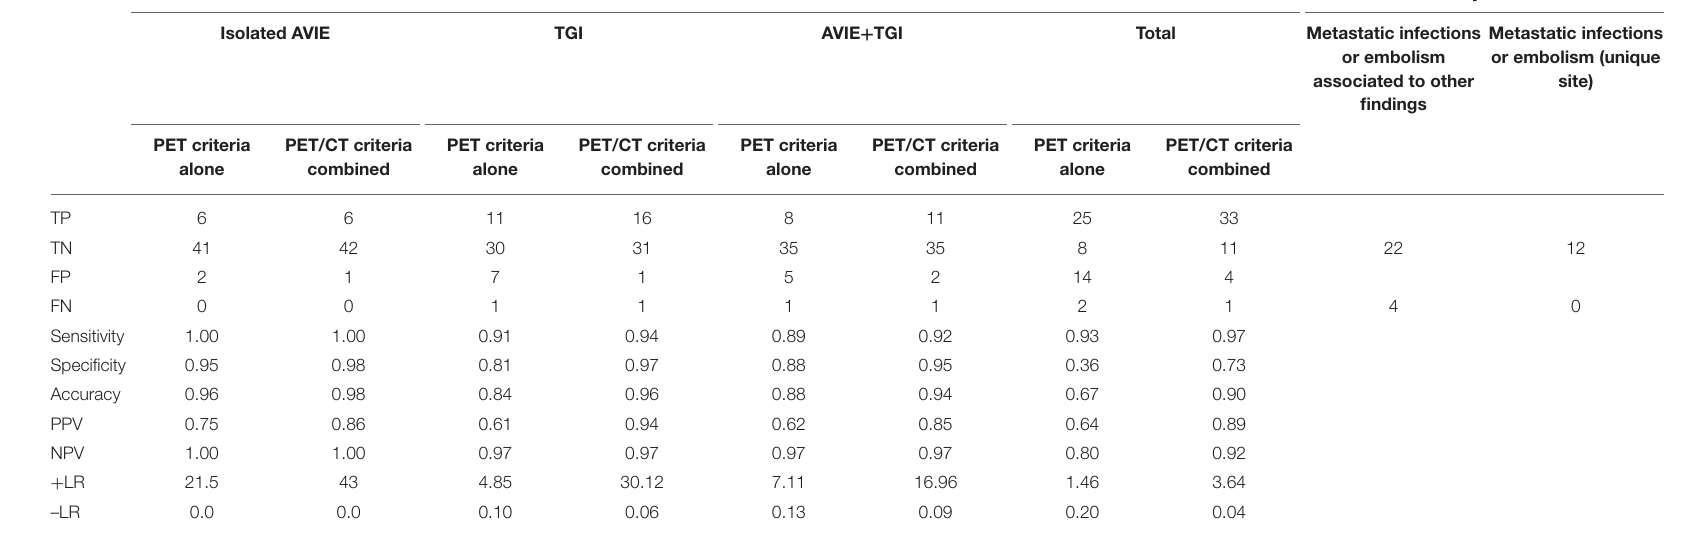
TABLE 3 | Diagnostic performance of [ 18 F]FDG PET/CT (49